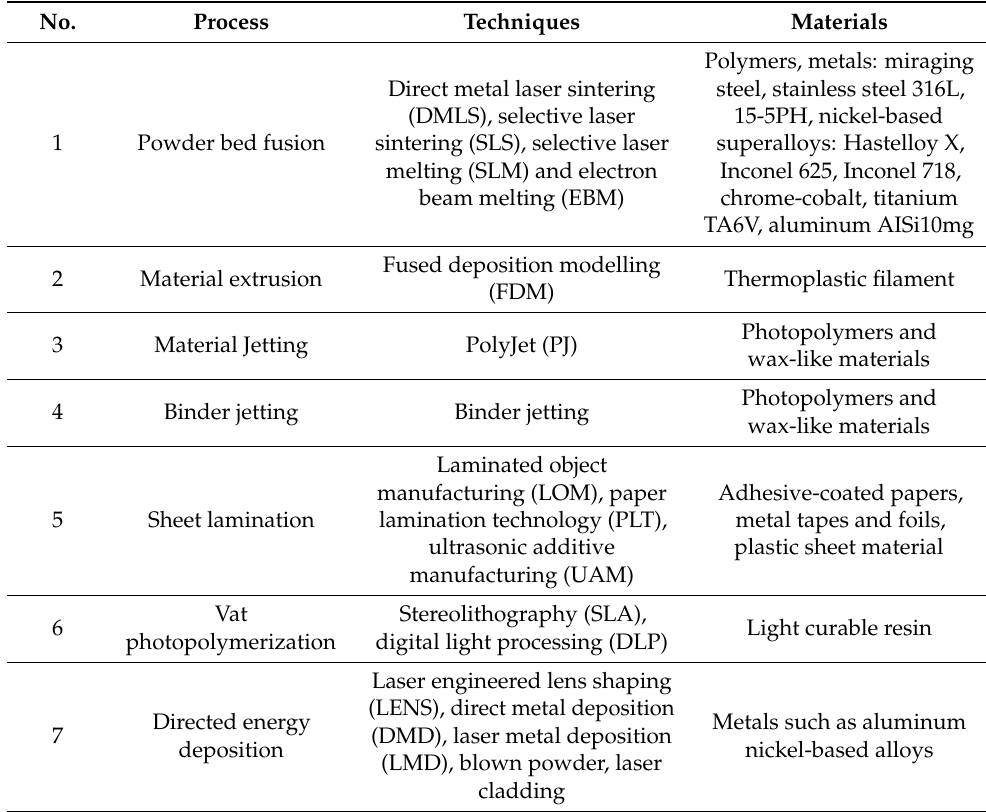
Table 1. Additive layer manufacturing processes (Farinia Group).